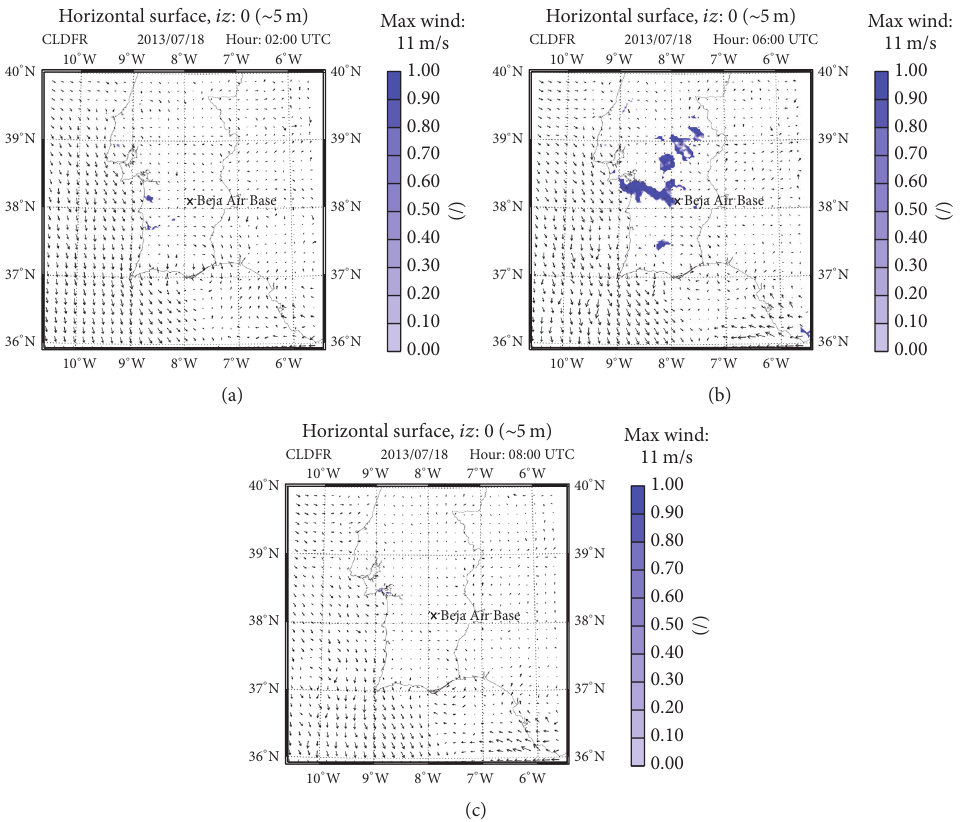
Figure 13: Simulation of cloud fraction (fog, blue scale) and flow (vectors) at 5 m height from the surface at 02:00, 06:00, and 08:00 UTC in D1 domain.